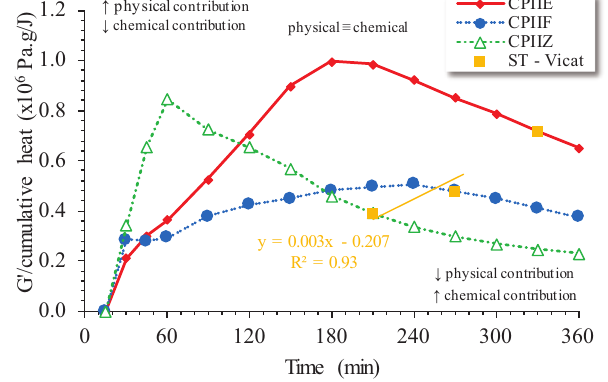
Figure 11 Relationship between setting time, measured by Vicat test, G’, and the ratio G’/cumulative heat, represent both chemical and physical contribution to